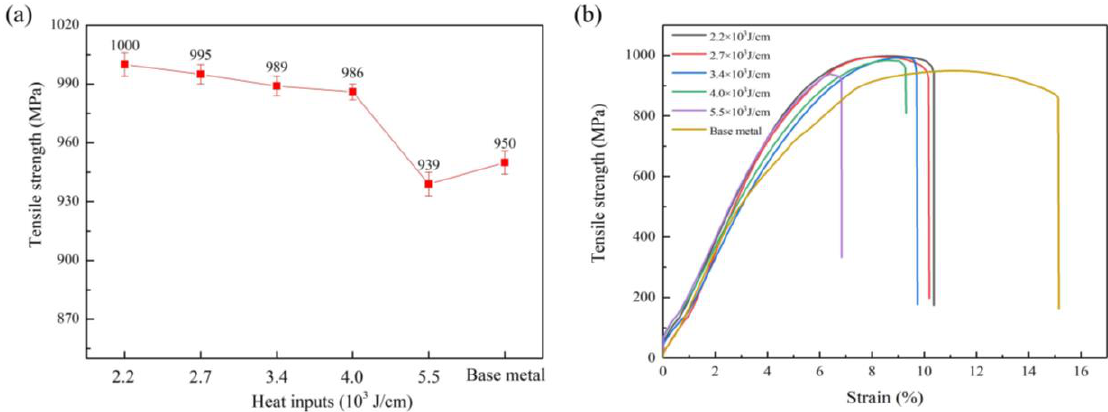
Figure 8. ( a ) Tensile strength of the joints for different heat inputs, ( b ) Stress-strain curves of dissimilar weld seam.